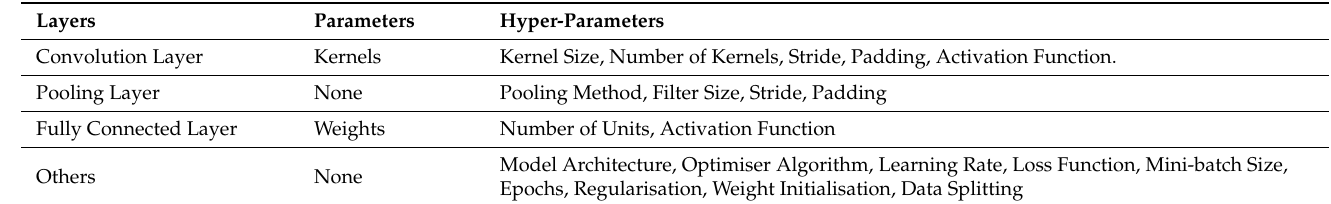
Table 3. Hyper-parameters and parameters in Convolutional Neural